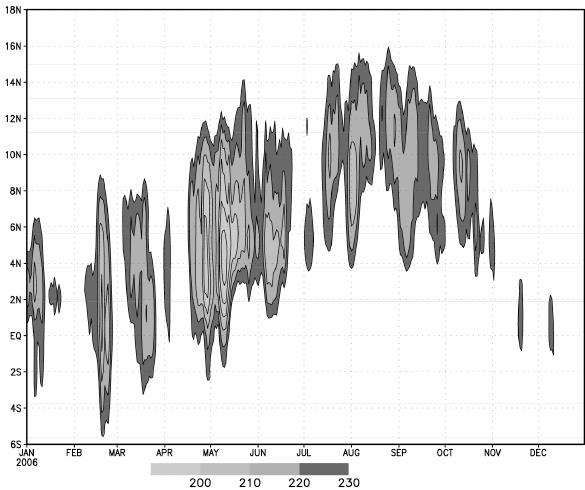
Figure 6. Time-latitude cross-section of the OLR field averaged on 10°W-10°E in 2006. A Fig. 6. Time-latitude cross-section of the OLR field averaged on moving average on +/-3 days have been applied to smooth the signal. The coastline is located 10 ◦ W–10 ◦ E in 2006. A moving average on ± 3 days have been approximately at 5°N. Only values lower than 230 Wm -2 are shaded. applied to smooth the signal. The coastline is located approximately at 5 ◦ N. Only values lower than 230Wm − 2 are